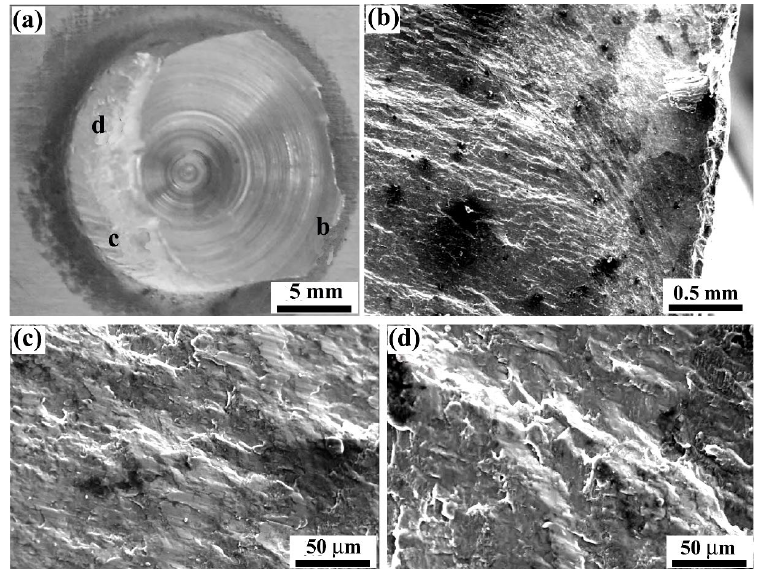
Figure 8. SEM images of the fracture surfaces in the C-FSSW sample at tool rotational speed of 900 rpm: ( a ) Fracture surface of the lower sheet; ( b – d ) magnified views at points ( b – d ) in ( a ), respectively.